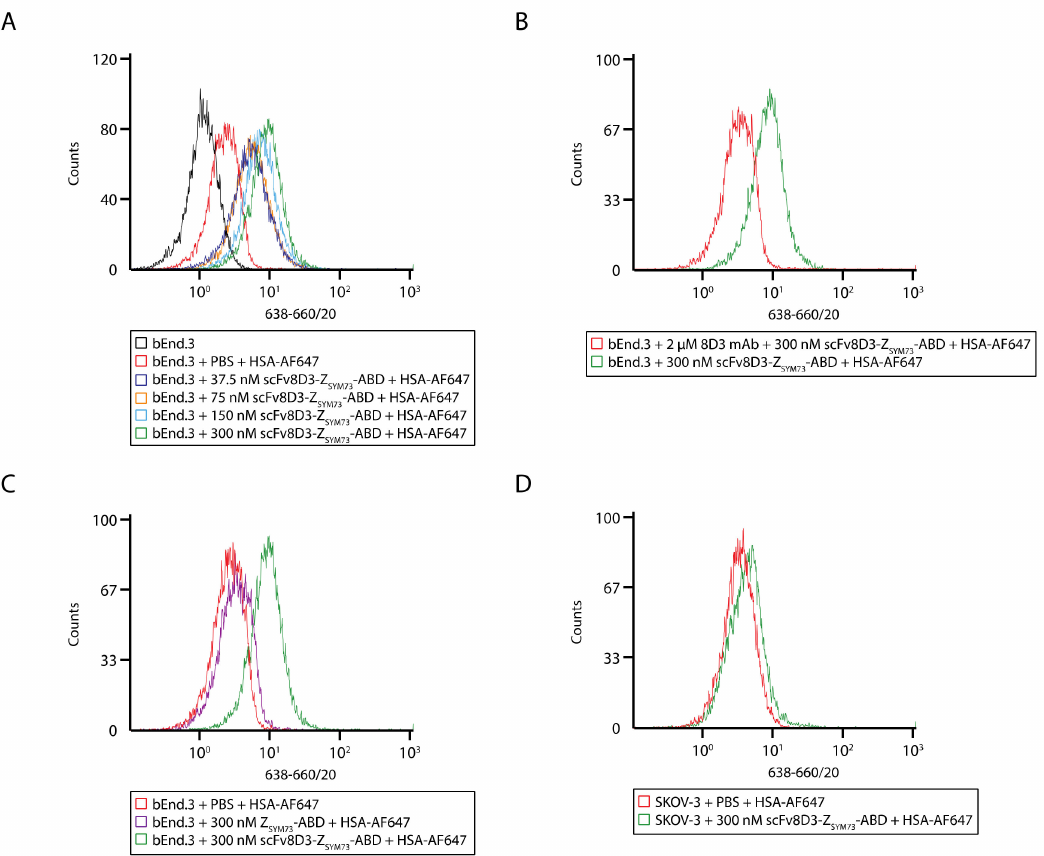
Figure 3. Flow-cytometric analysis of scFv8D3-Z SYM73 -ABD binding to cells. ( A ) Representative histograms showing results from the flow-cytometric analysis of bEnd.3 cells treated with 37.5 nM, 75 nM, 150 nM, and 300 nM scFv8D3-Z SYM73 -ABD. As a control, cells labeled only with HSA-AF647 and unlabeled cells were analyzed. ( B ) Representative histograms showing results from a blocking experiment using the parental mAb 8D3. ( C ) Representative histograms showing results from a control experiment using Z SYM73 -ABD. The MFI for cells treated with scFv8D3-Z SYM73 -ABD was 8.8 ± 0.2